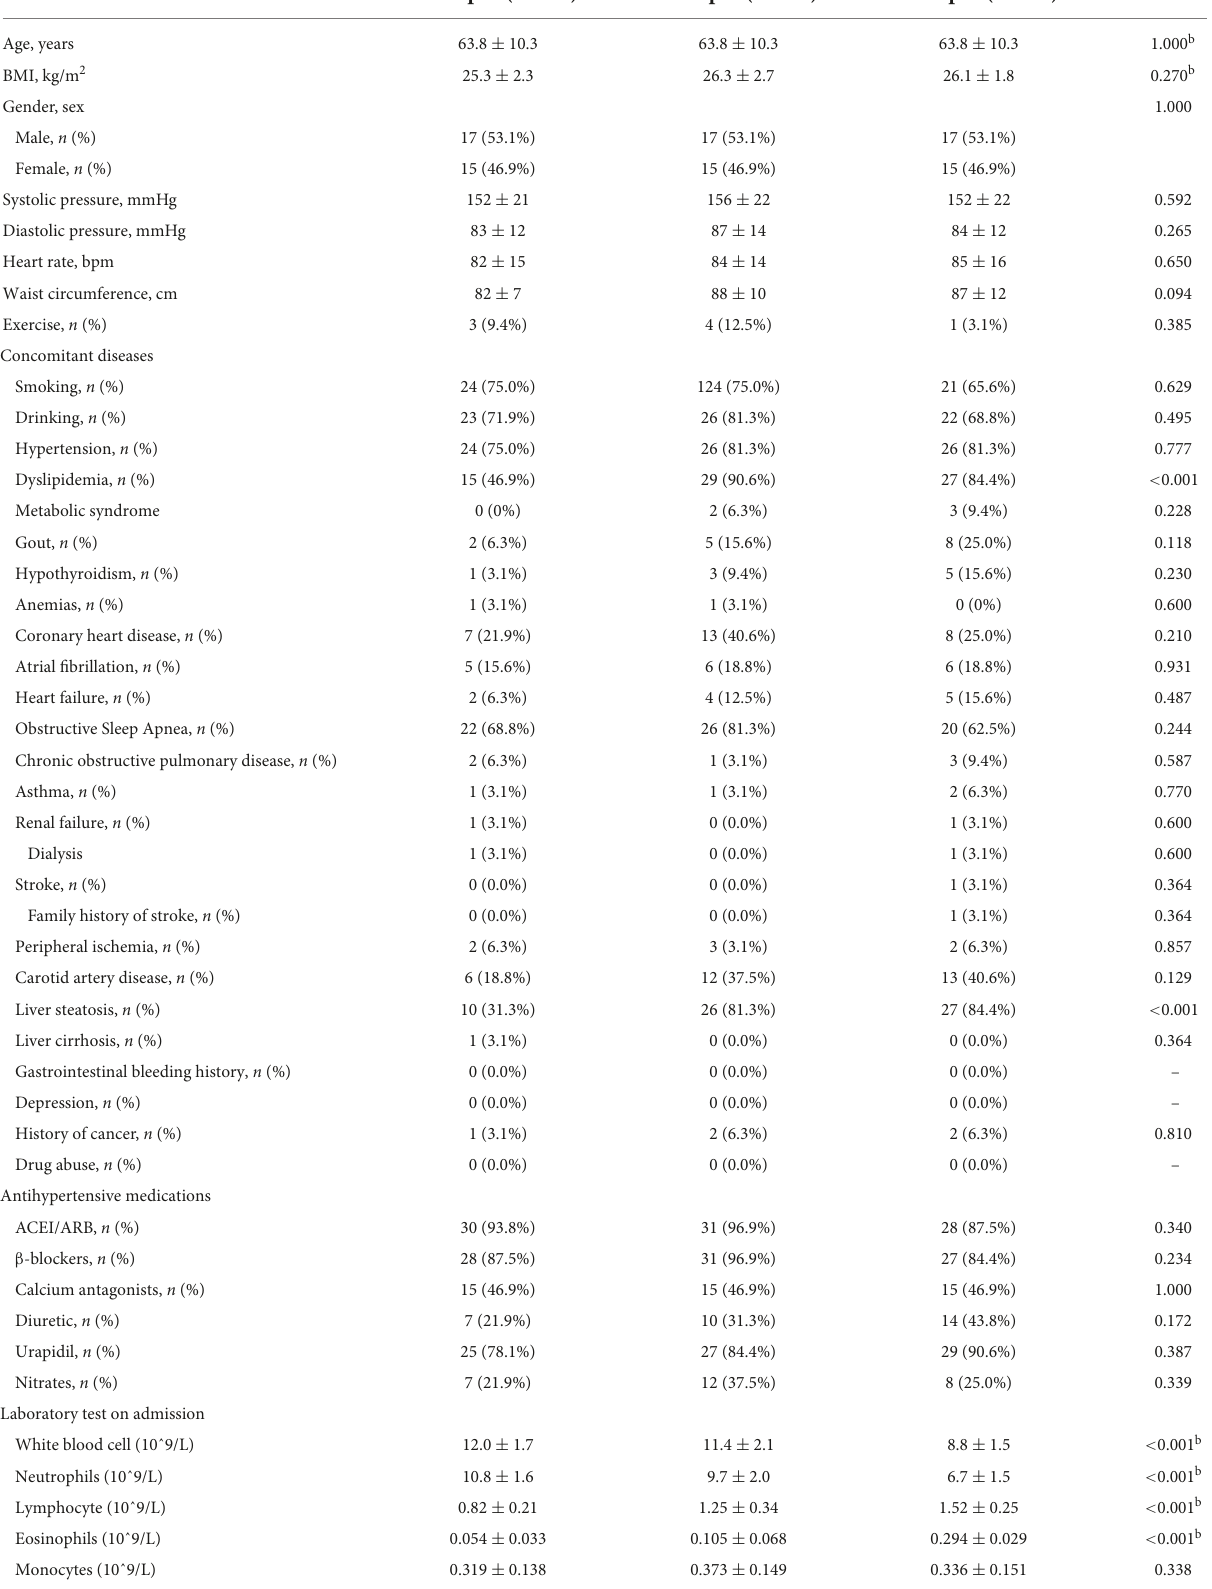
TABLE 1 Baseline characteristics a